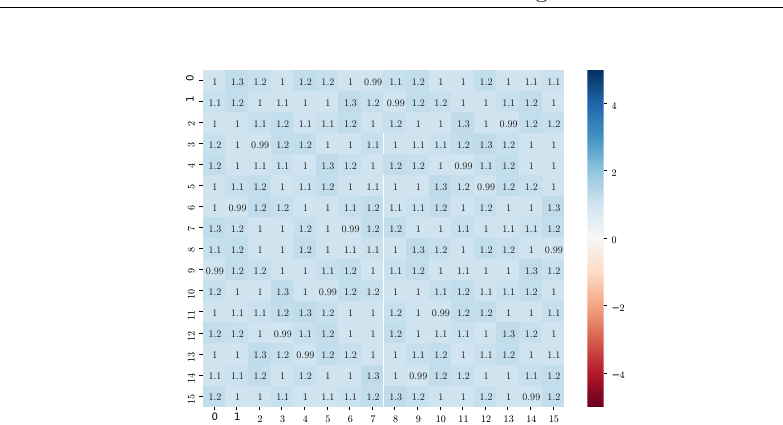
Figure 2: Theoretical index-dependent means from the equation system for our four-round distinguisher for the AES , in multiples of | µ deviations from the mean of the PRP. AES − µ rand | Each cell represents the result for the active input cell in the plaintexts ( y -axis) and the tested inactive cell ( x -axis) after four rounds without the final MixColumns operation. 1 . 0 means that the distinguisher matches our prediction